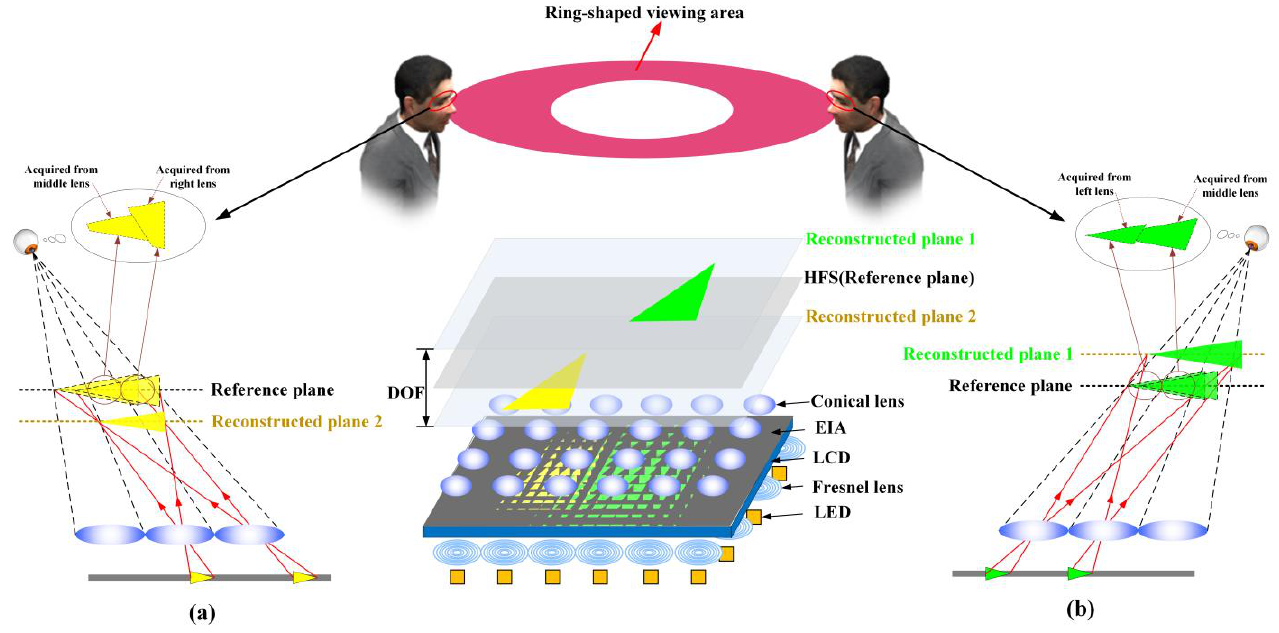
Figure 2. Facet-braiding phenomenon: ( a ) Inverse displacement, ( b ) direct